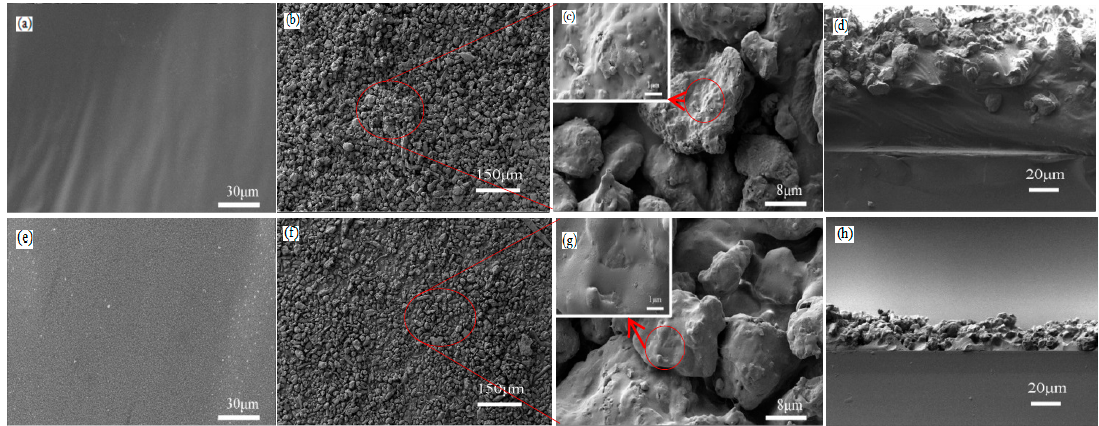
Figure 2. ( a ) Surface morphology of ( a ) the double-sided tape; ( b ) the D coating; ( c ) the L-CNC particles, with a high-magnification image inset; ( d ) the cross-sections of the D coating; ( e ) the surface morphology of the quick-setting epoxy; ( f ) the E coating; ( g ) the L-CNC particles, with a high-magnification image inset; and ( h ) the cross-sections of the E coating.